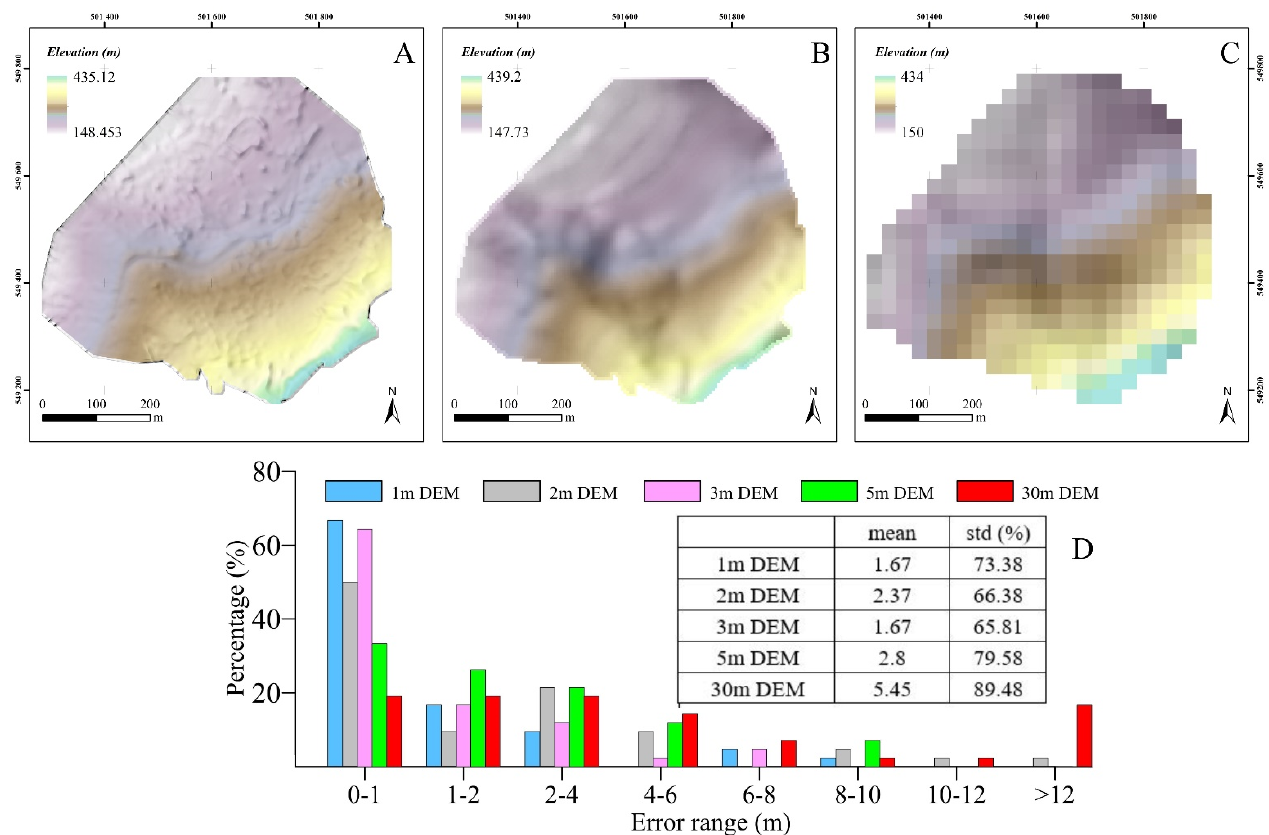
Figure 3. DEMs used for simulating the 2018 event. ( A ) UAV-derived DEM. ( B ) 5 m DEM. ( C ) SRTM 30 m DEM. ( D ) Vertical error distribution for the three DEMs used in this study.